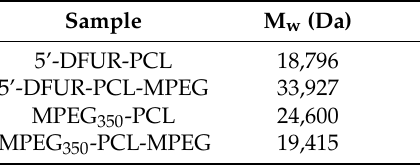
Figure 1. Synthetic scheme of ( A ) 5’-DFUR-PCL, ( B ) 5’-DFUR-PCL-COOH, ( C ) 5’-DFUR-PCL-NHS, and ( D ) 5’-DFUR-PCL-MPEG. Table 1. Characterization of 5’-DFUR-PCL-MPEG and MPEG 350 -PCL-MPEG amphiphilic